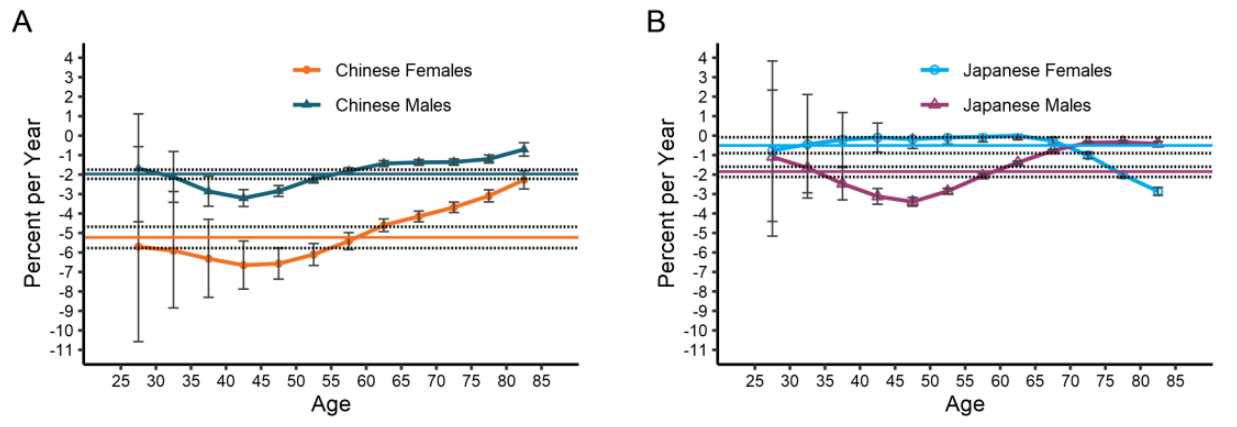
Figure 4. The local drift with net drift values for esophageal cancer mortality for males and females in China ( A ) and Japan ( B ). Net drift values are depicted as solid lines with dashed lines representing their 95% CI. Error bars represent the 95% CI for the local drift values. Table 2. The local drifts and net drifts for China and Japan (%). China Japan Drift